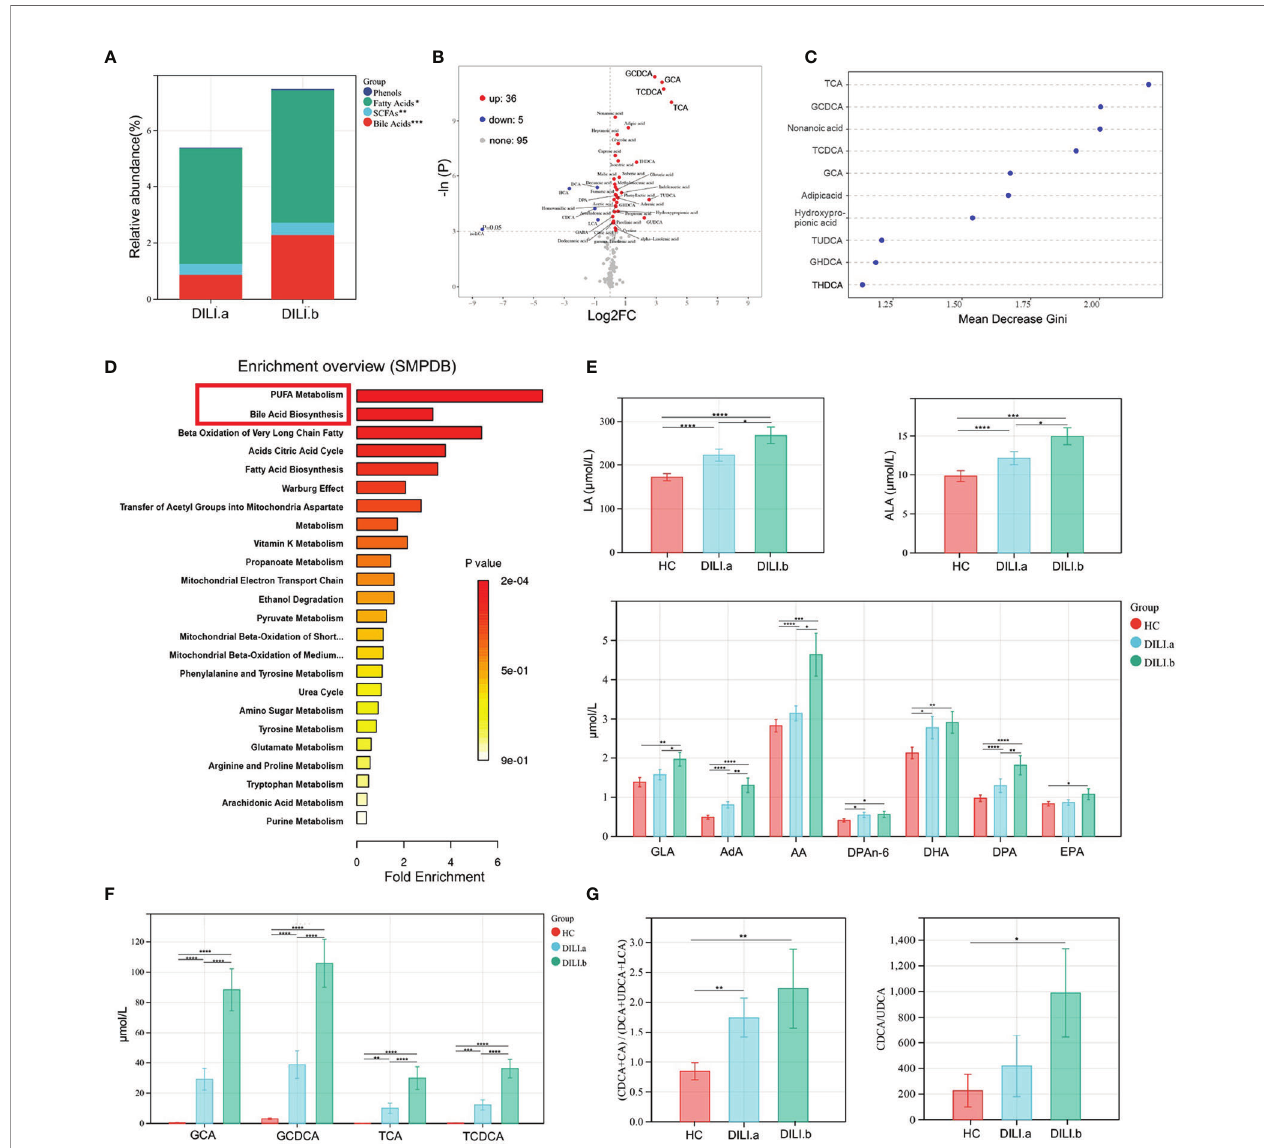
FIGURE 3 | Examination of the metabolic pro fi les of DILI with different severity. DILI patients were categorized as mild (Grade 1), moderate (Grade 2), severe (Grade 3) and liver failure (Grade 4) groups. Grade 1 and Grade 2 were de fi ned as DILI.a group, and Grade 3 and Grade 4 were de fi ned as DILI.b group. (A) The relative abundance of differential metabolite classes between different groups of DILI. (B) Volcano plot of the most signi fi cant metabolite changes comparing DILI.a with DILI.b group. (C) Importance scores of top 10 important differential metabolites by RF between DILI.a and DILI.b. (D) A pathway analysis used to discover the different metabolic characteristics between DILI.a and DILI.b (based on SMPDB). (E, F) Boxplot of main differential bile acid and PUFAs. (G) Ratios of (CDCA+CA)/ (DCA+UDCA+LCA) and CDCA/UDCA in HC, DILI.a and DILI.b groups. *p < 0.05; **p < 0.01; ***p < 0.001; ****p < 0.0001. RF, random forest; SCFA, short chain fatty acids; ALA, a -linolenic acid; LA, linoleic acid; AA, arachidonic acid; DPA, docosapentaenoic acid; GLA, gamma-linolenic acid; AdA, adrenic acid; CDCA, chenodeoxycholic Acid; CA, cholic acid; DCA, deoxycholic acid; UDCA, ursodeoxycholic acid; LCA, lithocholic